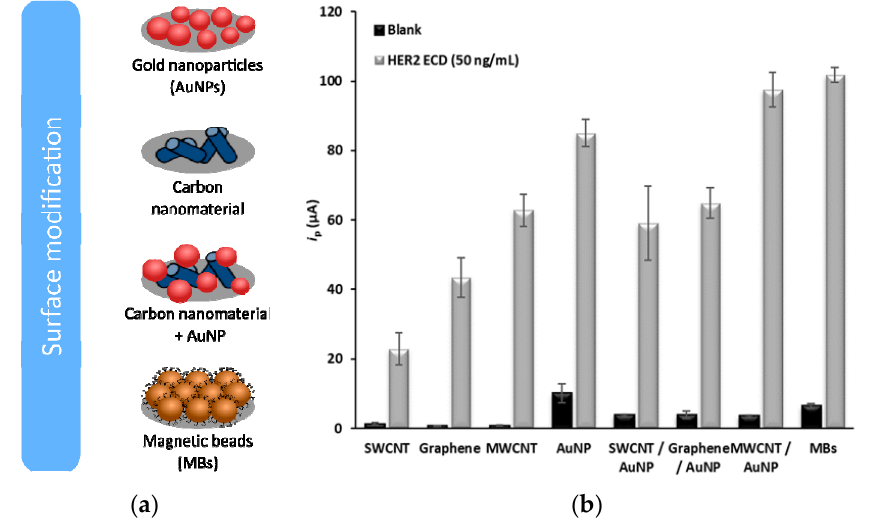
Figure 1. Sensor optimization. ( a ) Schematic representation of the carbon-, gold- and magnetic based